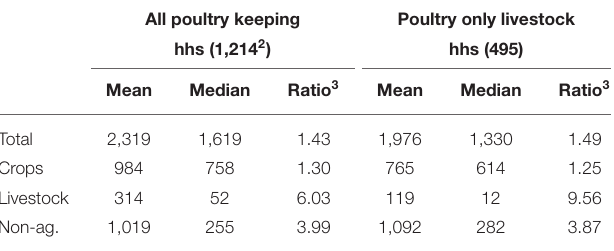
TABLE 2 | Mean and median annual income (thousand TZ Sh. 1 ) of rural poultry-keeping households (hhs) in Tanzania in 2012/2013 by income source. All poultry keeping Poultry only